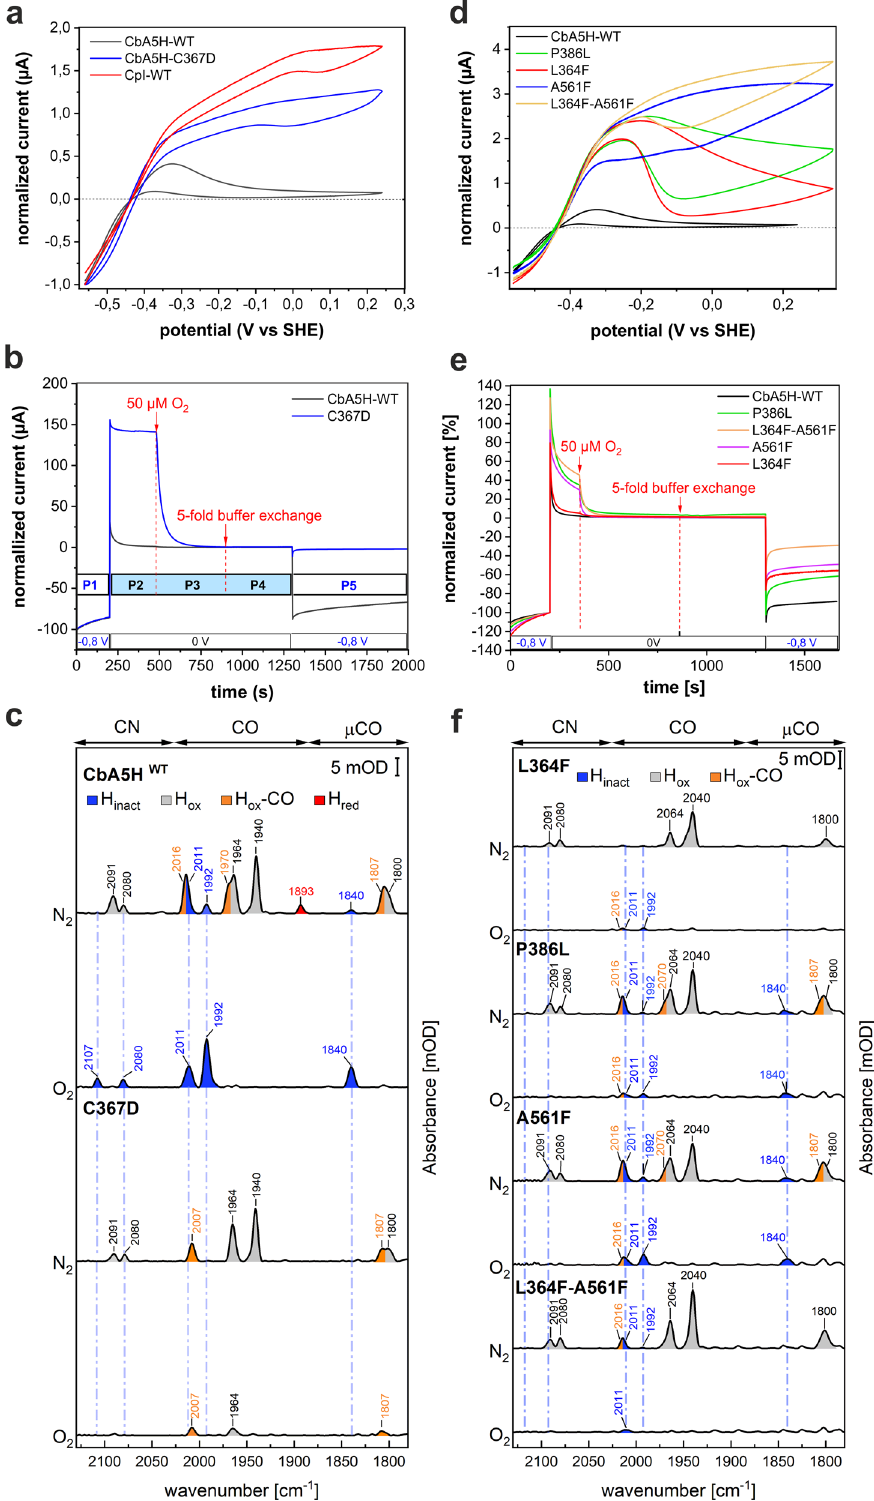
inactivation, as recently observed in another electrochemical investigation of CbA5H 31 . This inactivation at relatively low potential is reminiscent of the shift in the onset of anaerobic inactivation to lower potentials observed for DdH and HydA1 in the presence of exogenous sul fi de 30 . When subsequently sweeping